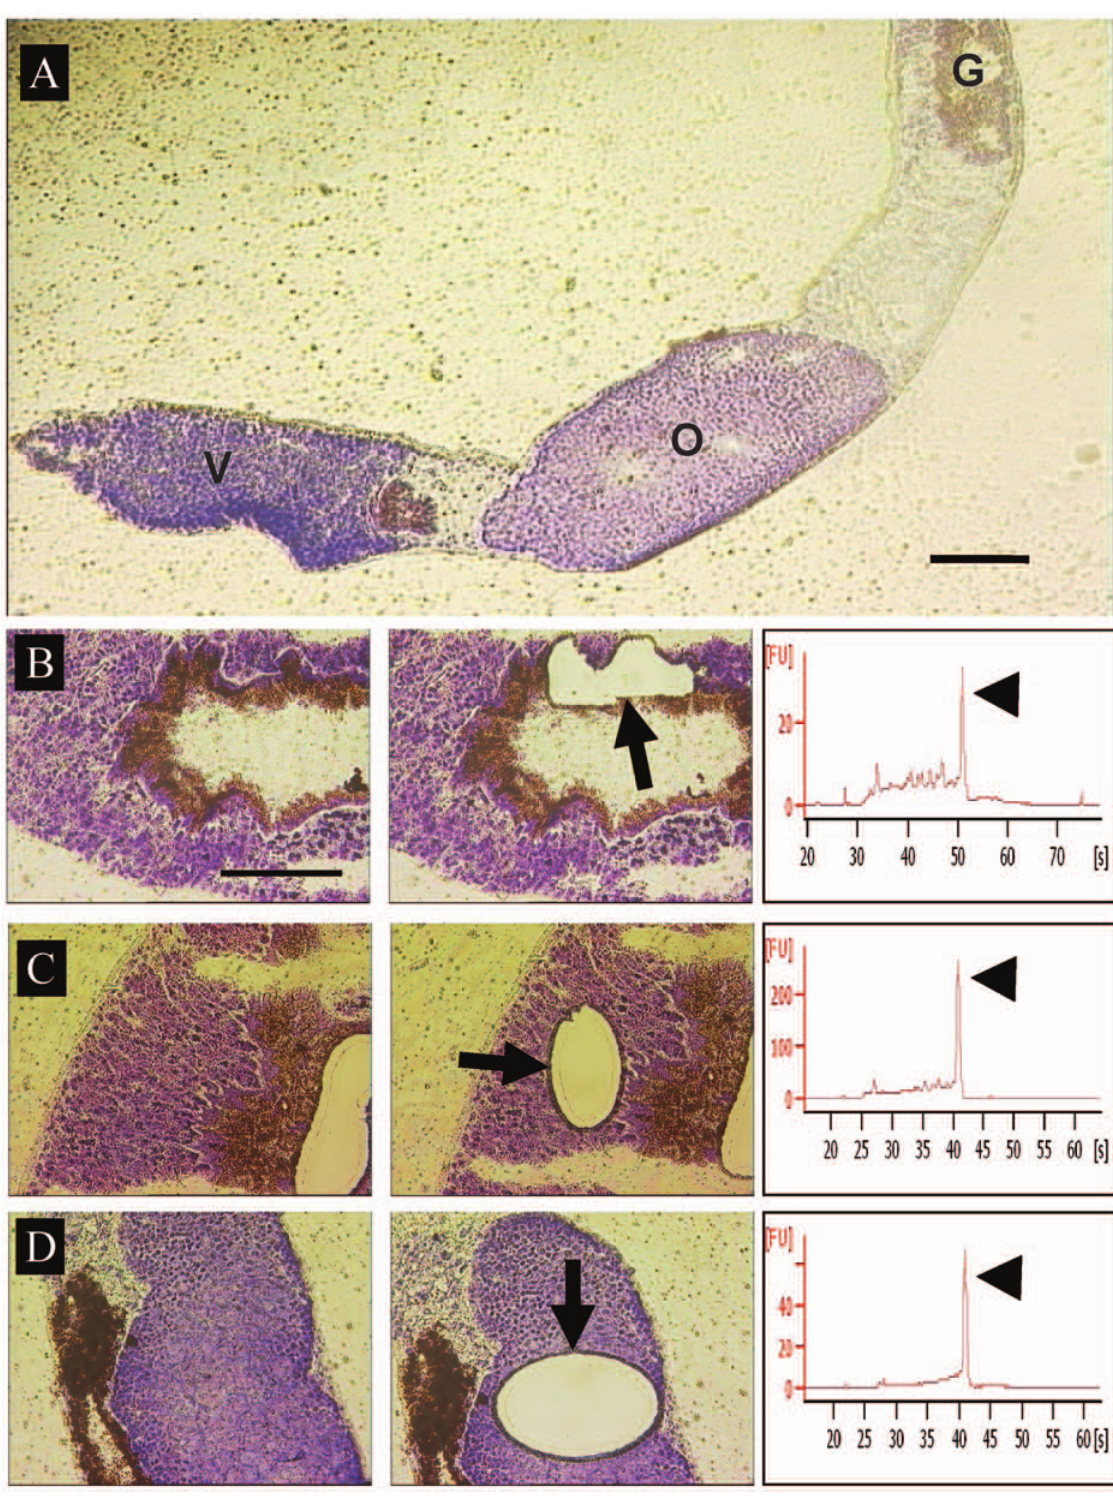
Figure 1. Laser microdissection of S.japonicum tissues. (A) Longitudinal section through female, showing morphology of gastrodermis (G), ovary (O), and vitelline tissue (V) from toluidine blue-stained cryostat sections. Bar=100 m m. (B) Gastrodermis. Bar=100 m m (C) Vitellarium and (D) Ovary; before (left panels) and after (centre) LMM. For each tissue, the region of microdissected tissue is indicated with an arrow. The panel on the right shows quality of total RNA from the three microdissected tissues determined using a Bioanalyzer. The prominent 18S ribosomal RNA band is indicated by the arrowhead and is an indication of the fidelity of the total RNA. A distinct 28S band is never visible in total RNA fractions of schistosomes.